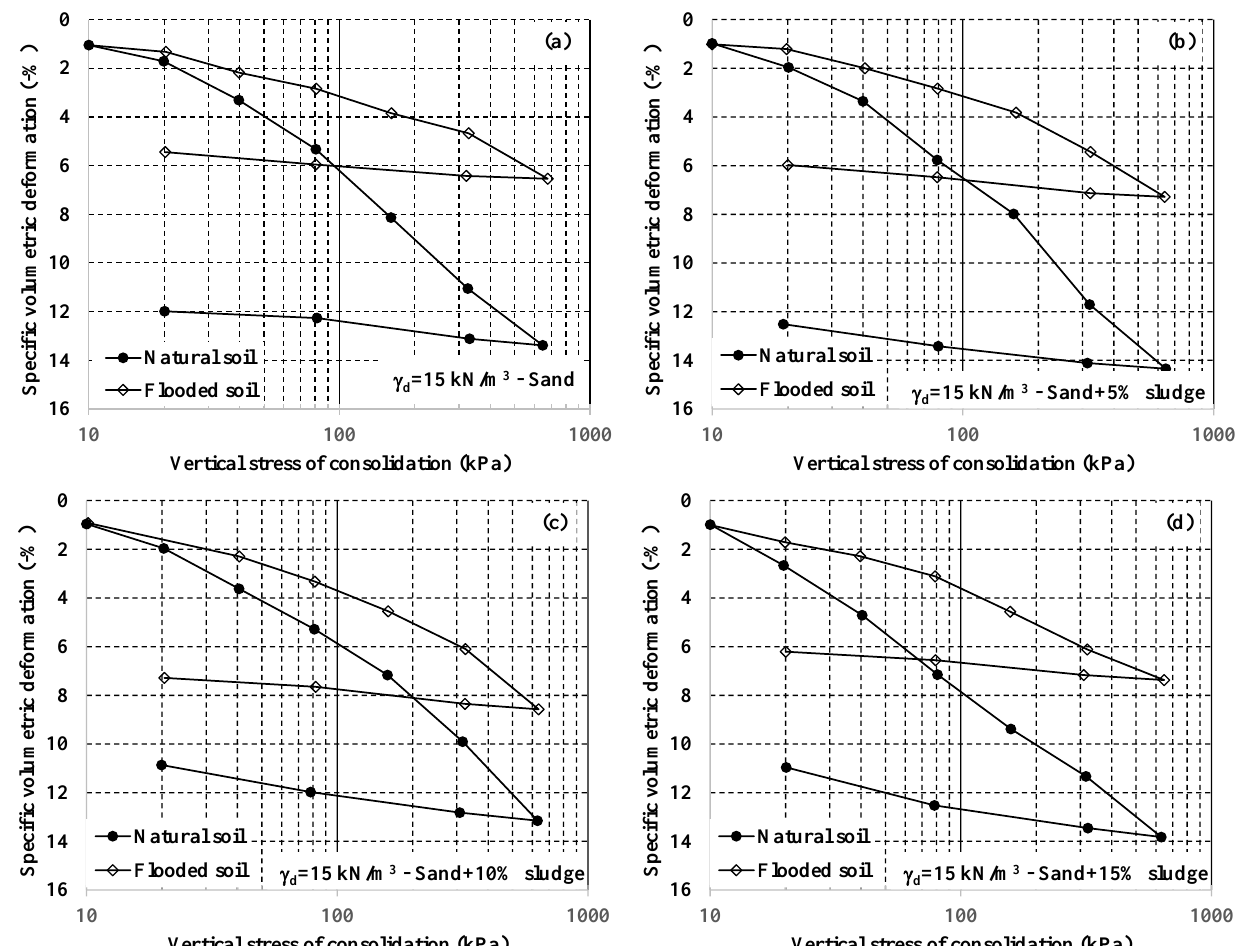
Figure 13. Variation of the void index with the vertical stress of consolidation obtained through double oedometer tests, for dry apparent specific weight of 15.0 kN/m 3 : ( a ) sand, ( b ) sand plus 5% sewage sludge, ( c ) sand plus 10% sludge, ( d ) sand plus 15% sludge.